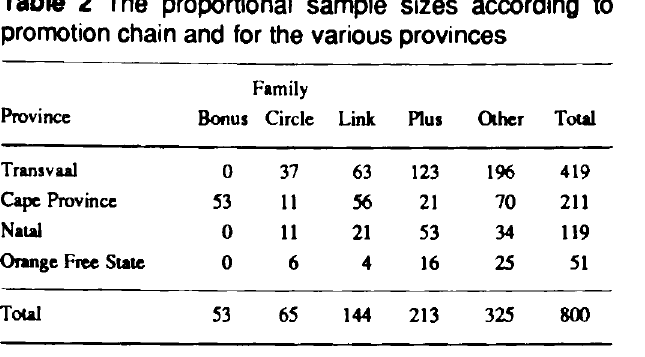
Table 2 The proportional sample sizes according